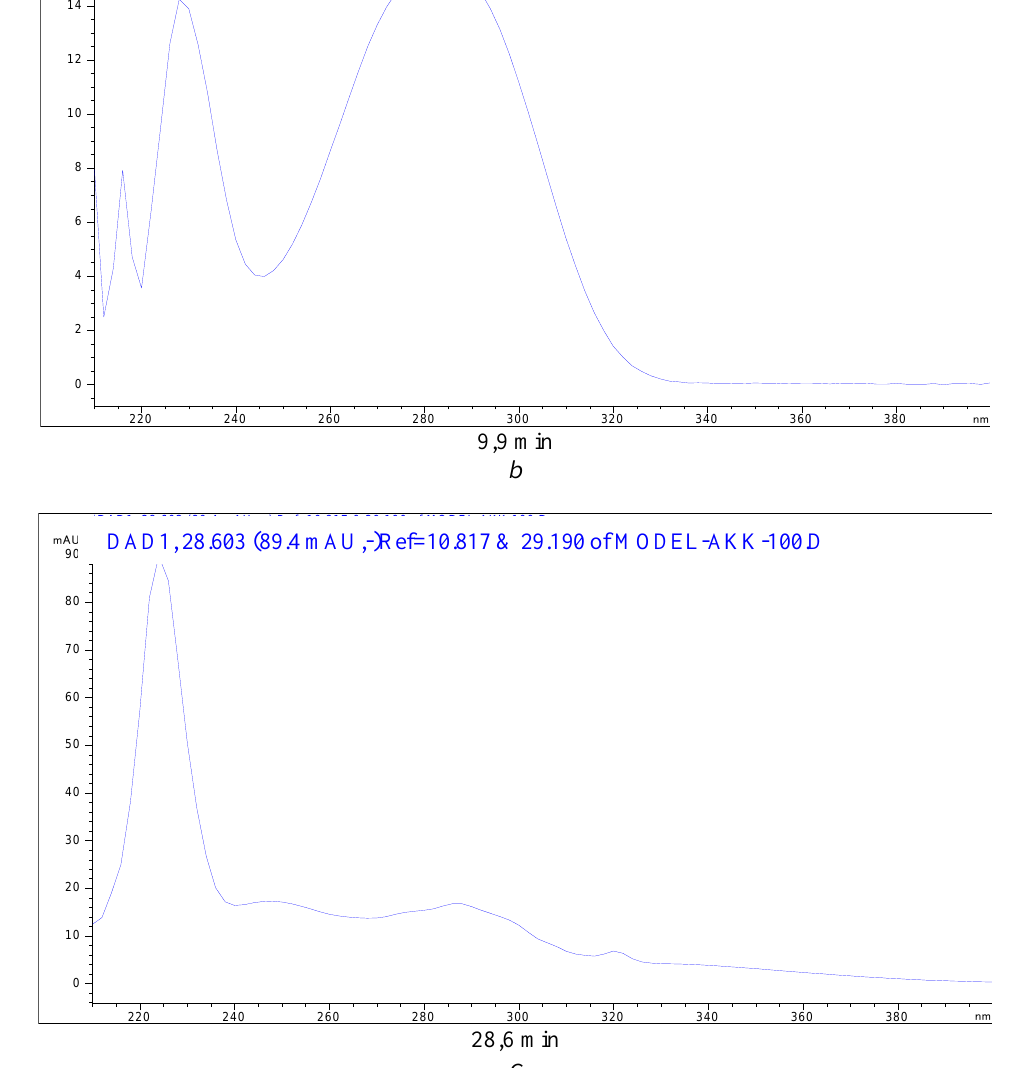
Fig. 3. UV spectra: а – dansyl chloride; b – para-aminobenzoic acid; c – aminocaproic acid